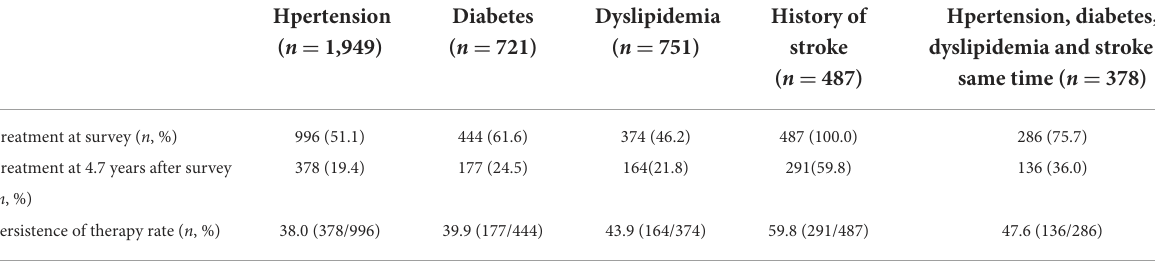
TABLE 2 Persistence of medications in the 2,698 high-risk stroke population.